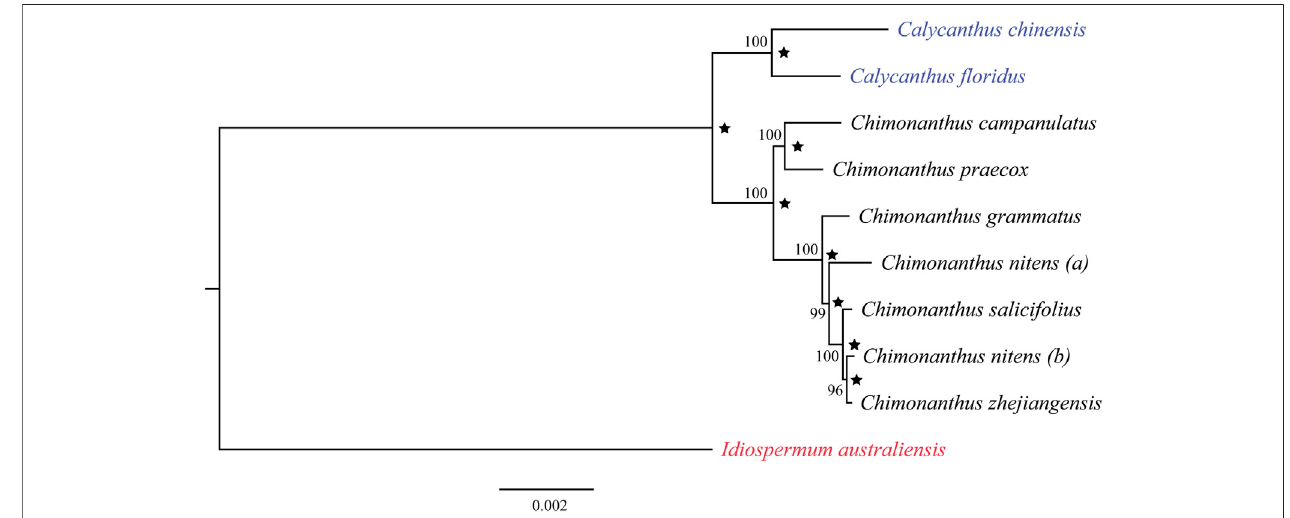
FIGURE 4 | Phylogenetic relationships among nine species in the family Calycanthaceae based on the maximum-likelihood analyses and Bayesian inference. Idiospermum australiense was used as the outgroup. Numbers at each node are bootstrap support values in 100 replicates. Star indicates Bayesian posterior probabilities above 0.95 from the BEAST analyses.